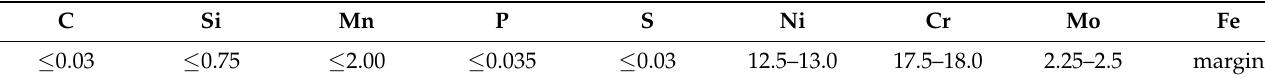
Table 1. 316L stainless steel chemical composition (Wt%).